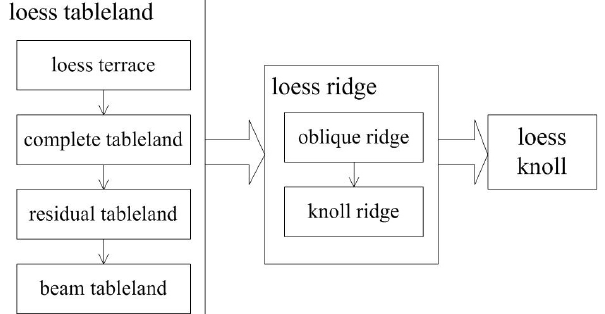
Figure 9. Transitional relationships among typical loess geomor- phological